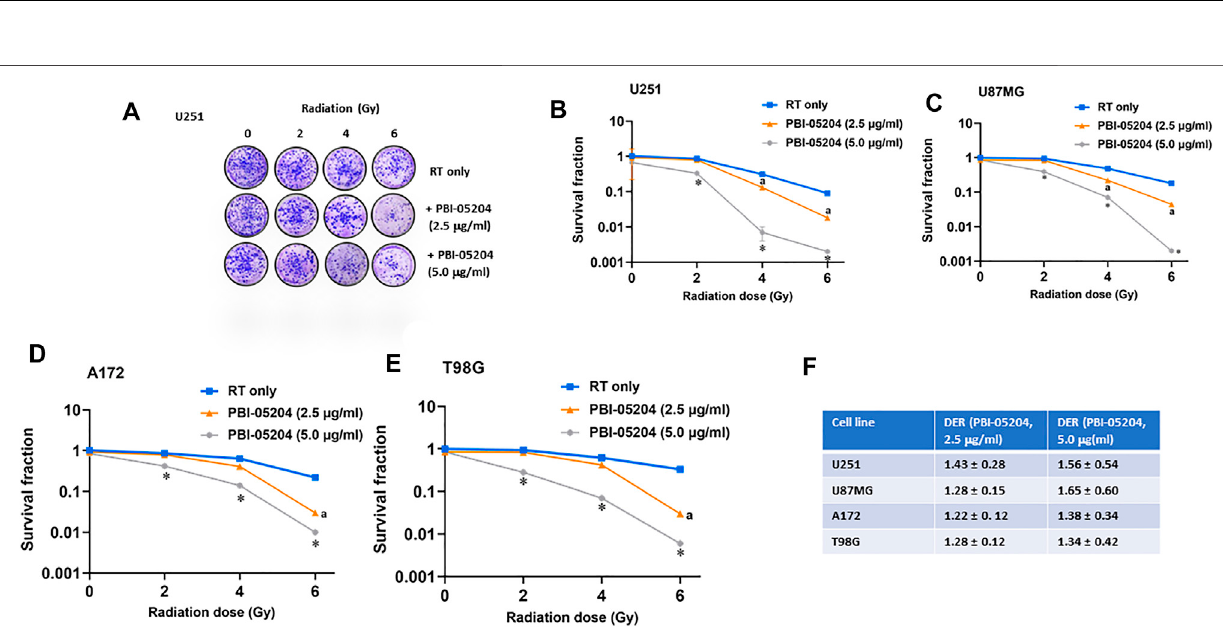
Frontiers in Pharmacology |